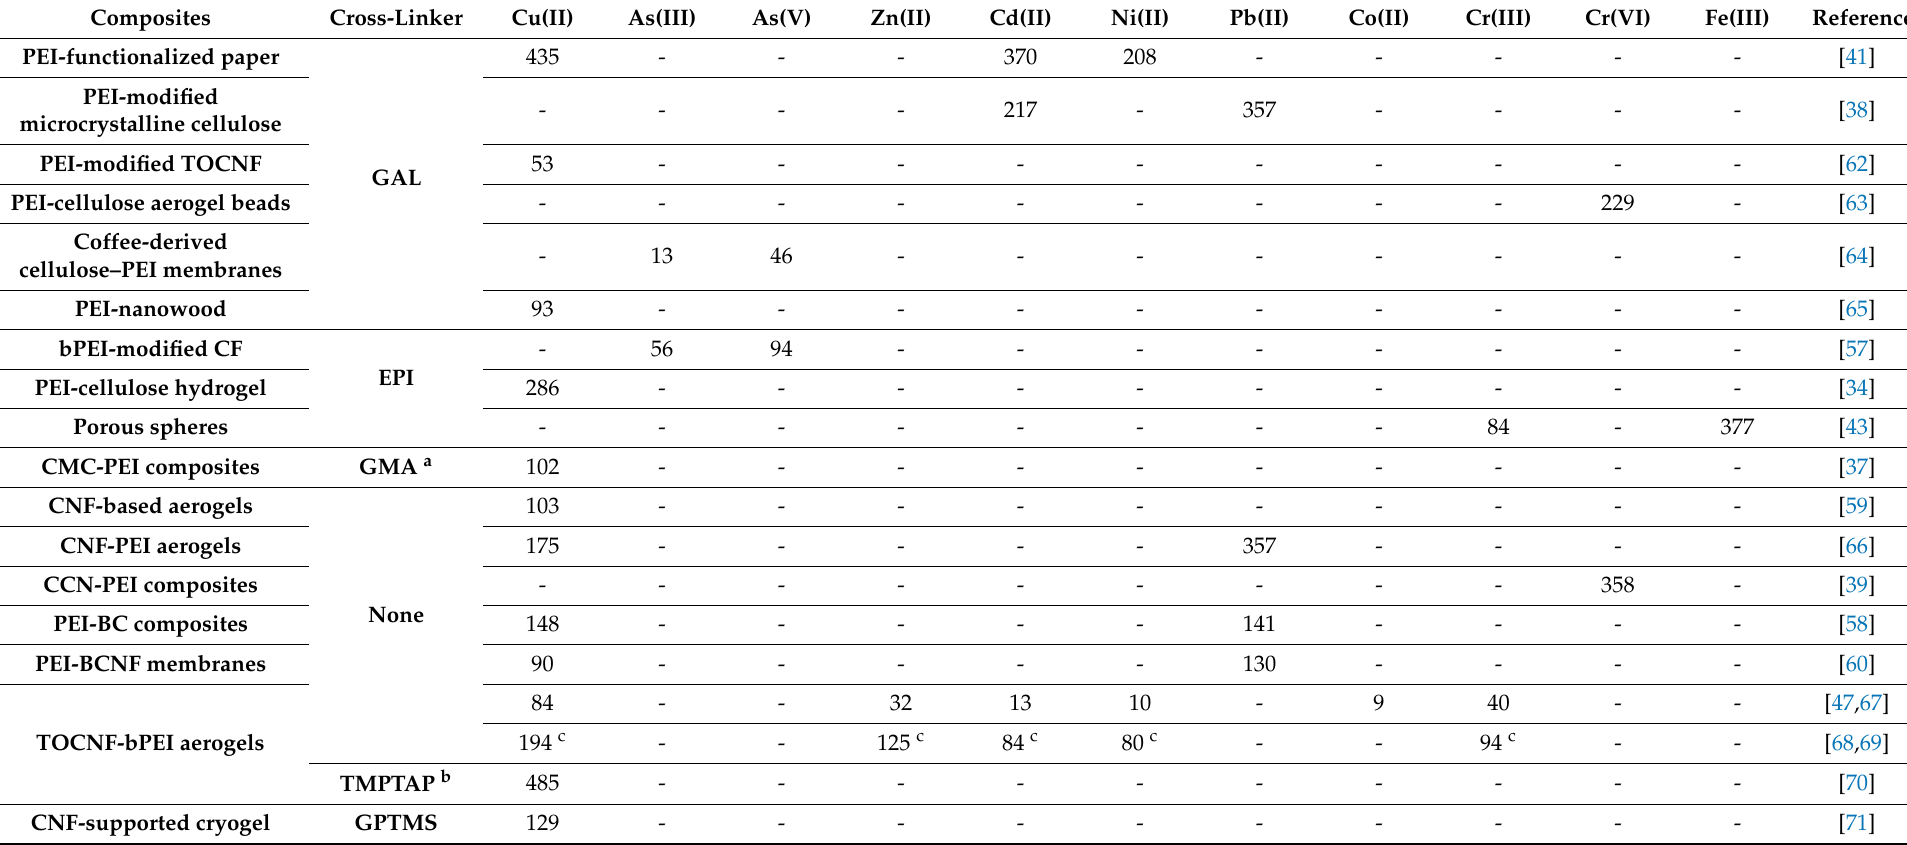
Table 2. General overview of cellulose–PEI composites for adsorption of heavy metals from water. The table shows the values of reported adsorption capacity for each composite expressed in mg · g − 1